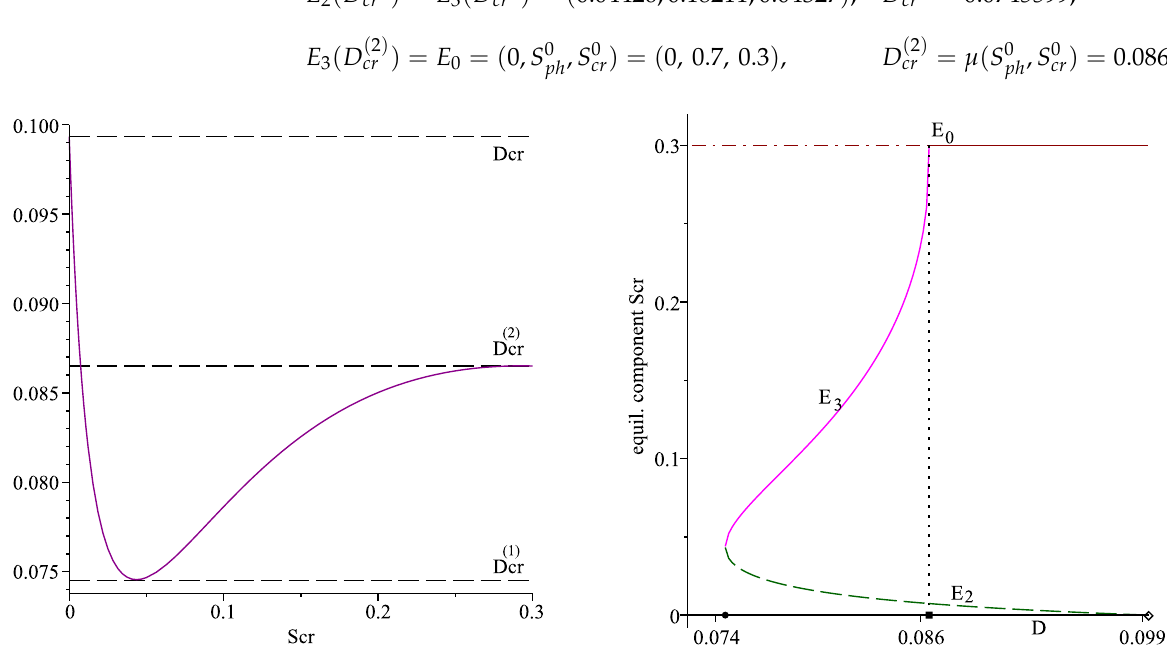
( 2 ) cr (dash 0 cr . On the horizontal axis, ( 2 ) cr .